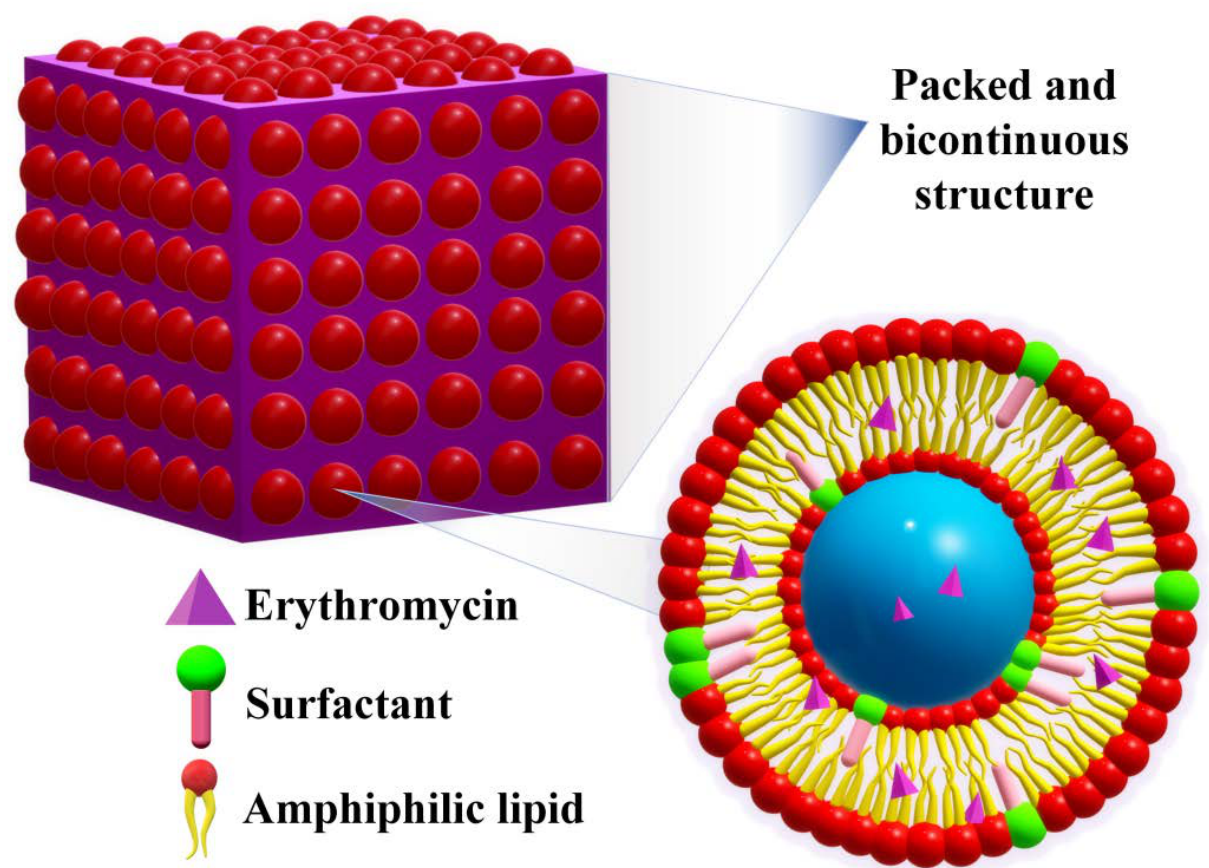
Figure 8 . Schematic representation of an ERY cubosome. Figure 8. Schematic representation of an ERY